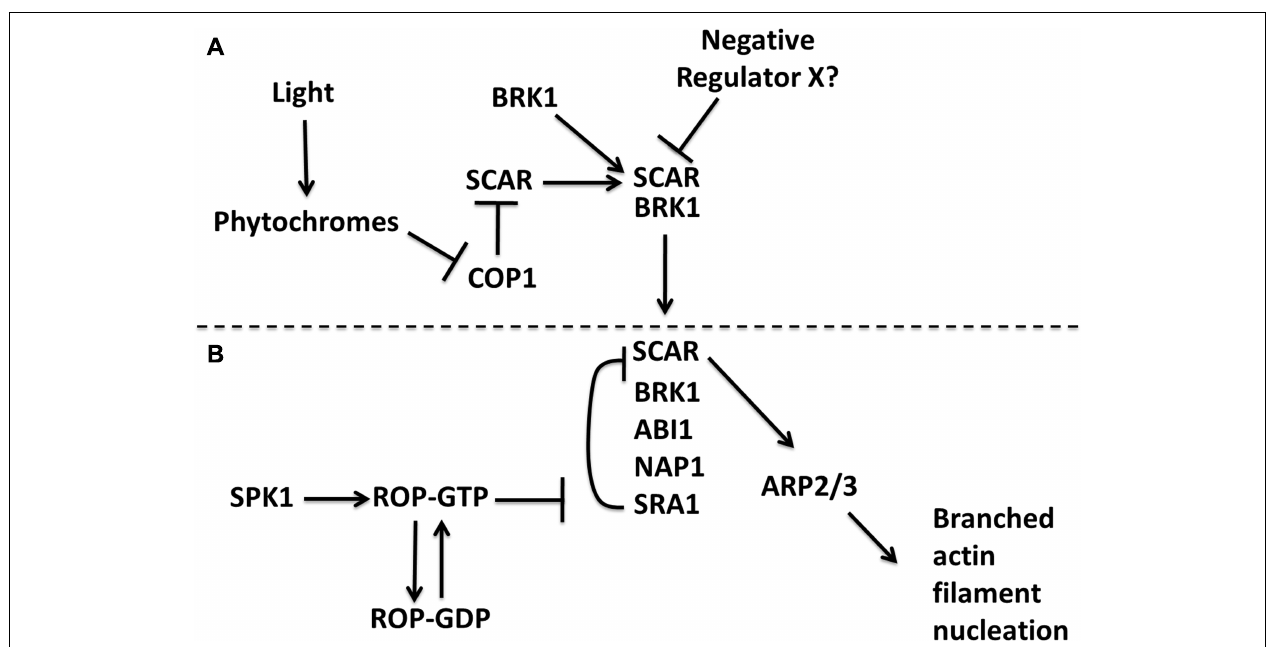
assembledW/SRC that forms when the BRK1–SCAR sub-complex associates with a proposed NAP1–SRA1–ABI sub-complex (B) . SPK1 generates activating ROP-GTP signals that antagonize SRA1-dependent trans -inhibition of SCAR.The output of the pathway is presumed to be the generation of a network of branched actin filaments.The dashed line emphasizes the distinct levels of control between partial and fully